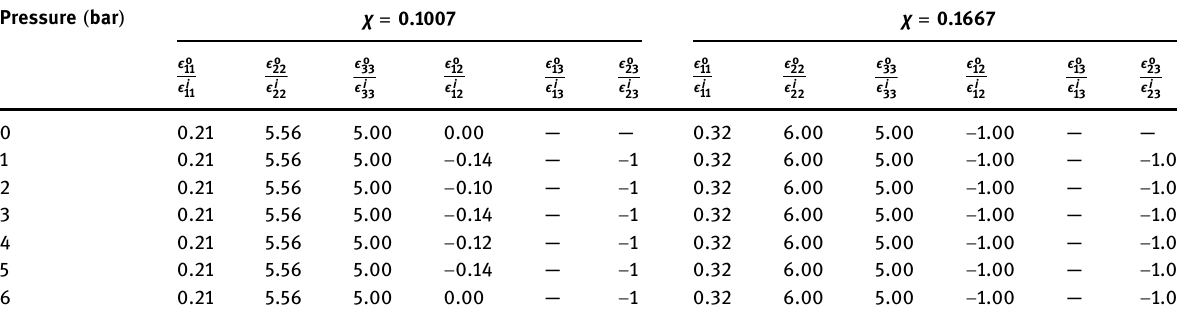
Table 7: Ratio of strain between inner and outer sheets Pressure ( bar